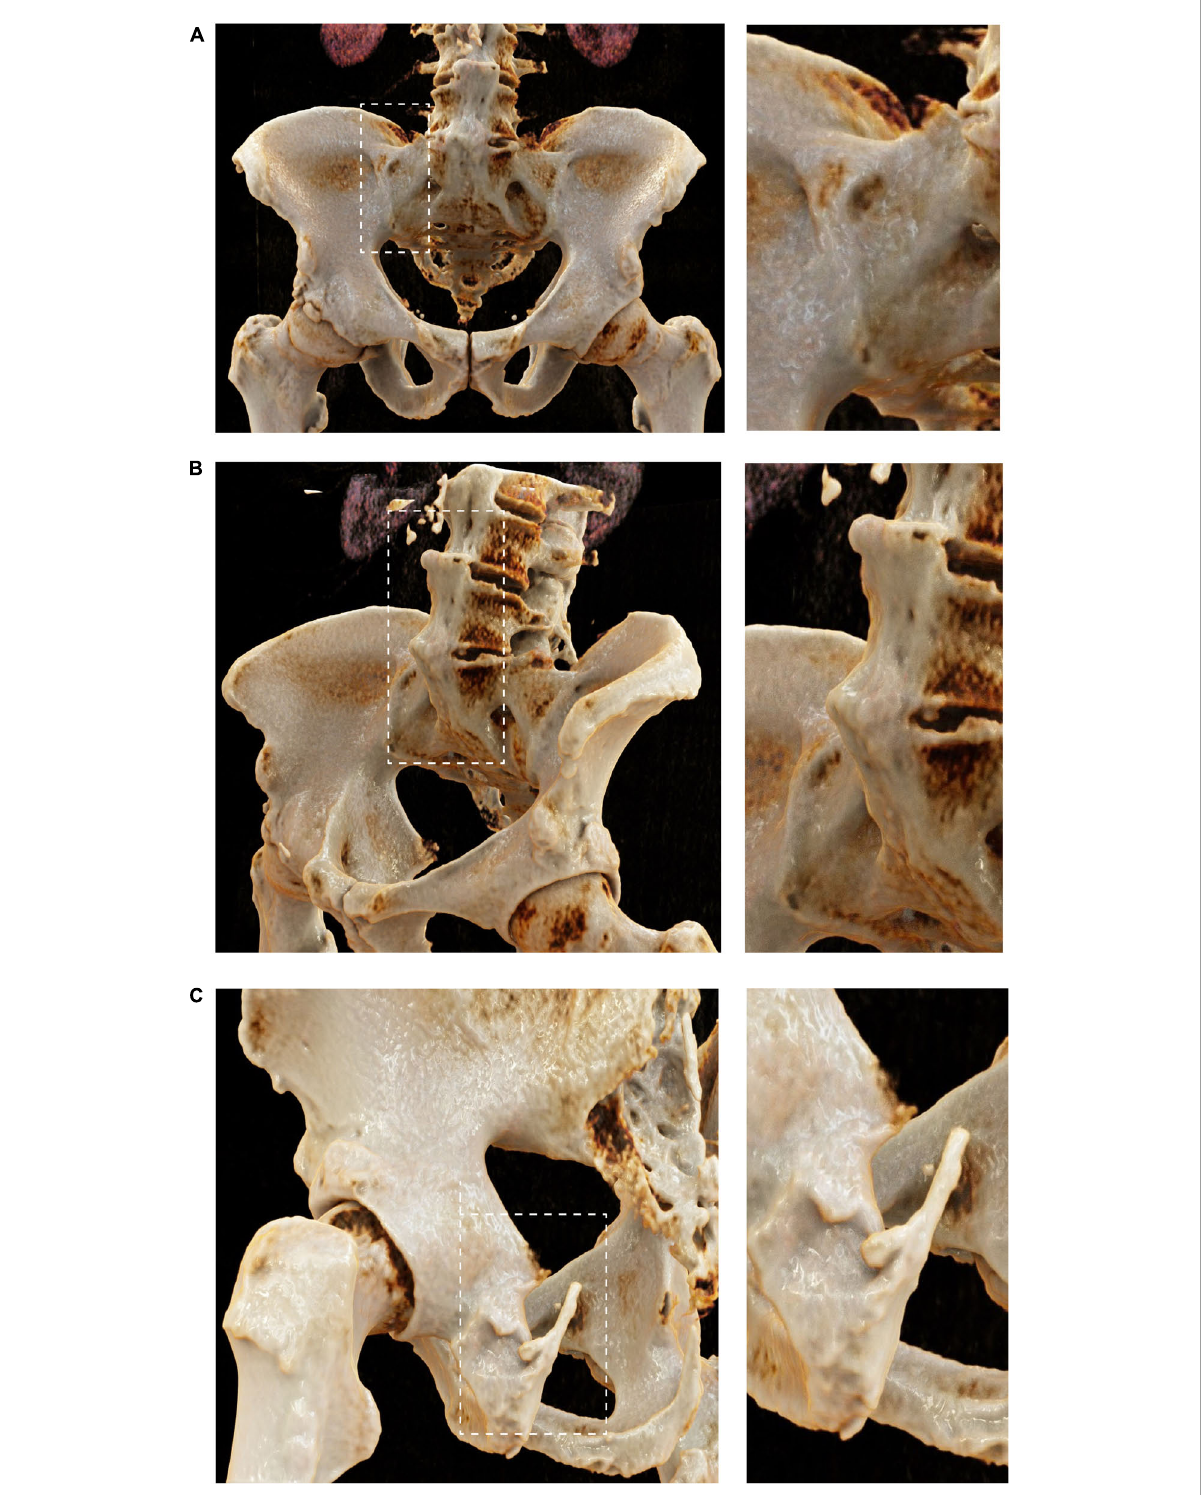
FIGURE2 Cinematic rendering of the pelvis and sacrum in axial spondyloarthritis. Cinematic rendering based on conventional CT images impressively showing sacroiliac ankylosis [ (A) overview and close-up], snydesmophyte formation at the ventral lumbar spine [ (B) overview and close up] and enthesiophyte formation at the ischial tuberosity [ (C) overview and close up]. CR close ups remarkably demonstrate the typical osteoproliferative pathologies, self-explaining the symptoms and pain these patients are